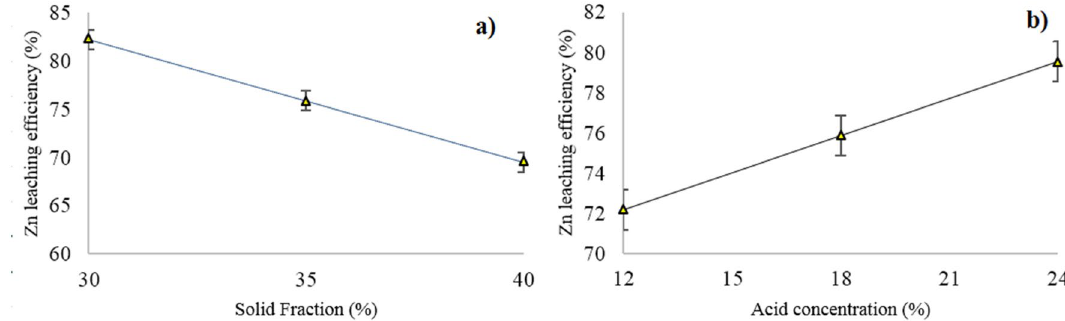
Figure 4. Effect of ( a ) solid fraction at H 2 SO 4 concentration of 18% and ( b ) H 2 SO 4 concentration at 30% solid fraction on the zinc leaching